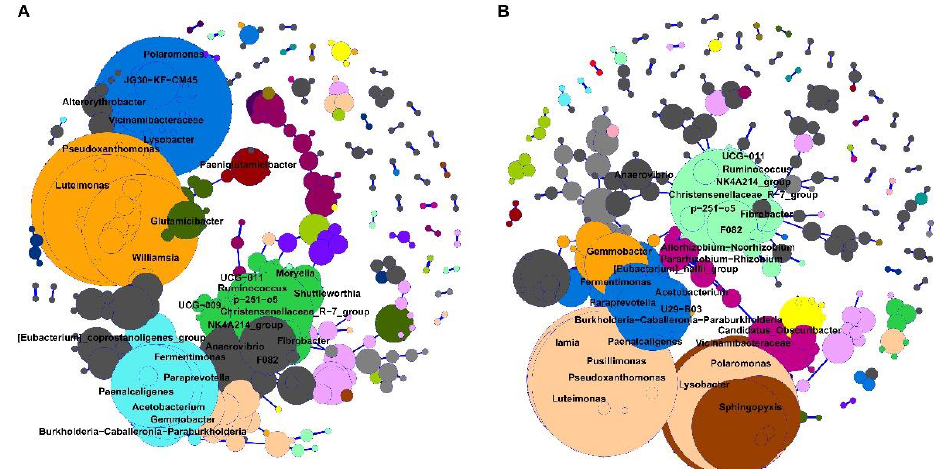
Figure 3. The bacterial network of brain microbiota. Bacterial networks were illustrated through genera with over 0.5 of rho value. In the network, the blue line indicates a positive correlation between the edges. The genus name is displayed on nodes with more than 5 edges. The node size and color corresponded to its total degree and sub-community, respectively. ( A ) Bacterial network for downer cattle. ( B ) Bacterial network for normal cattle.